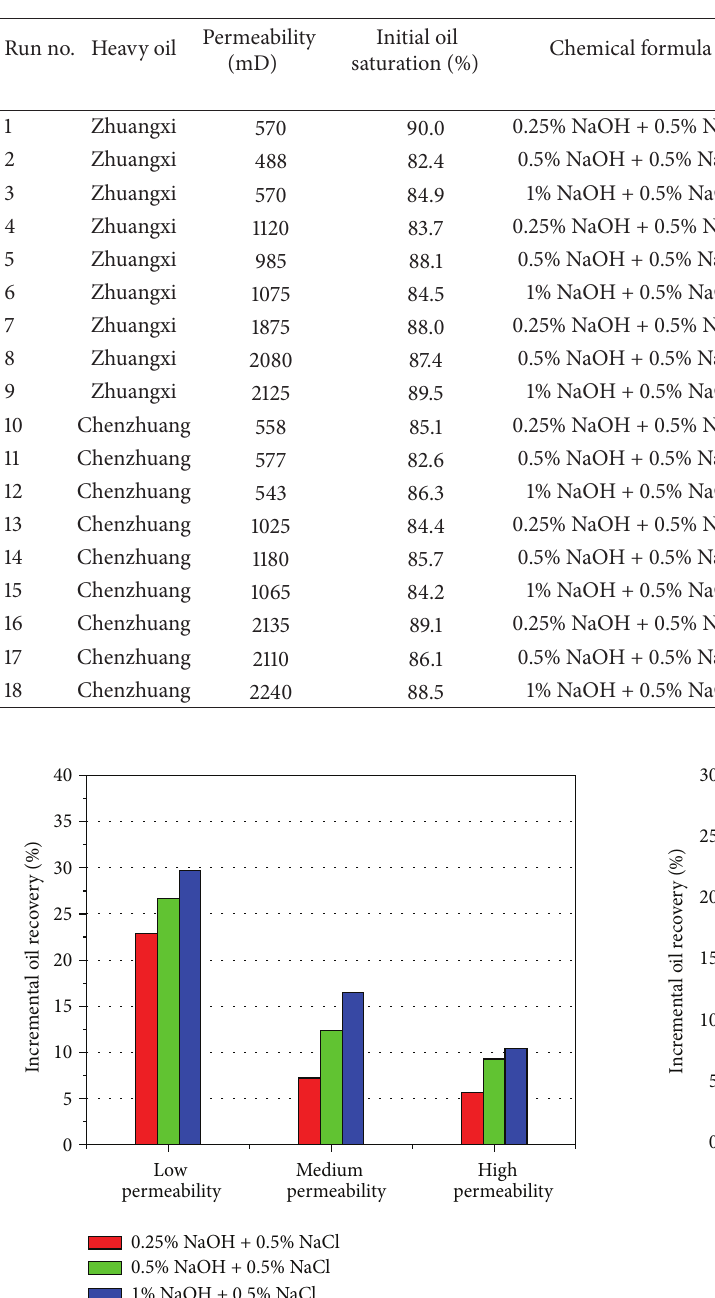
Table 2: Summary of sandpack flooding tests for different heavy oils.